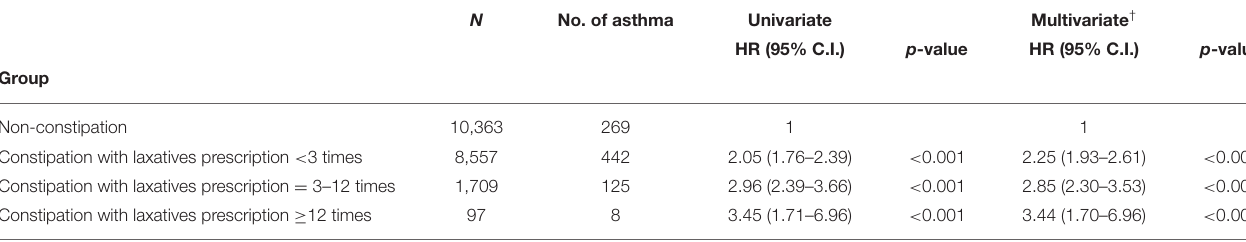
TABLE 4 | Cox proportional hazard model analysis for risk of asthma in constipated patients with prescription for laxatives.